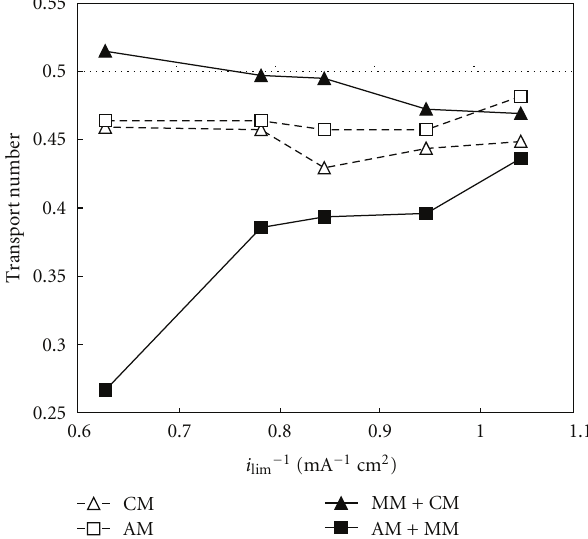
Figure 5: Transition time versus i lim − 2 in 0.01 MKCl solution. Symbols are inserted in the figure. Figure 6: Relation between transport number and various